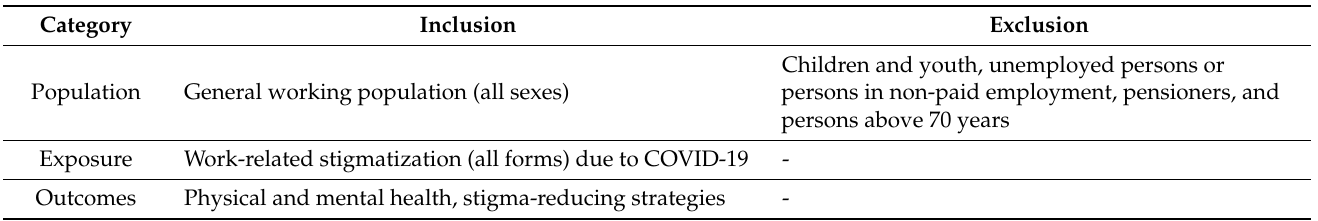
Table 2. Inclusion and exclusion criteria for the research question concerning health consequences of stigmatization (research question